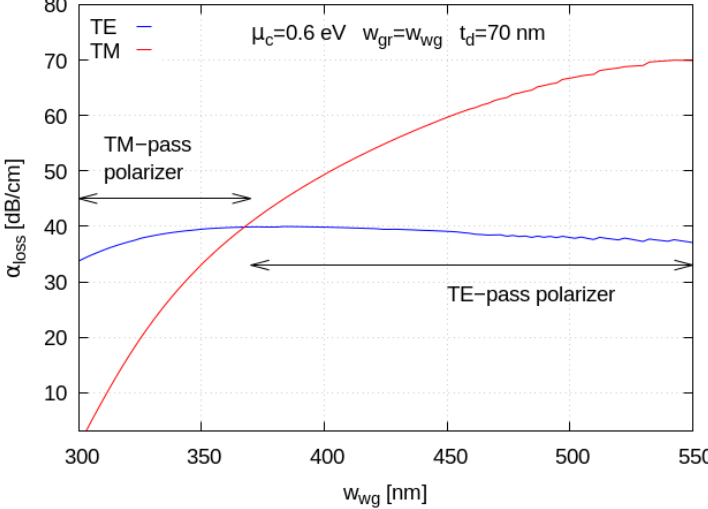
Figure 6. Waveguide loss as a function of the waveguide width. The graphene chemical potential value is taken as µ c = 0.6 eV and the light wavelength is set to 1.55 μ m, with a graphene electronic relaxation time τ = 20 fs.